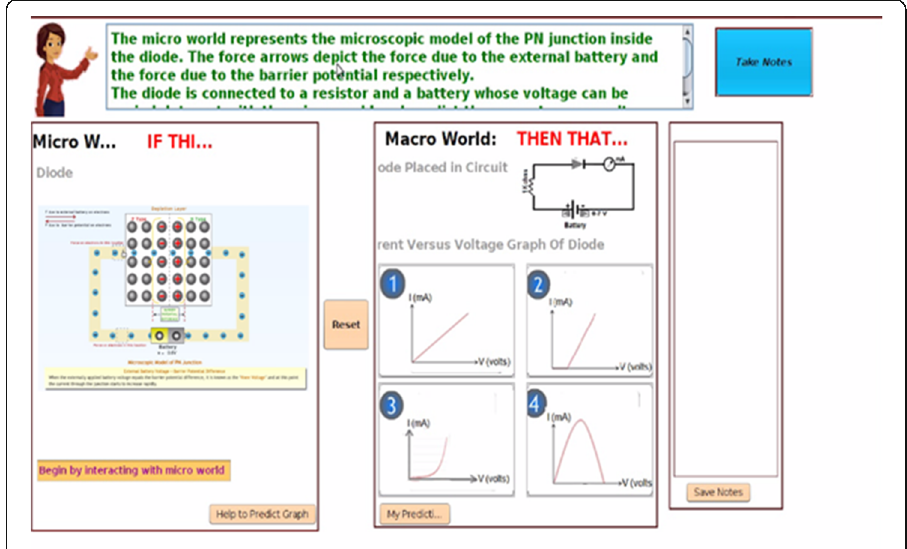
Fig. 11 MIC-O-MAP with the pedagogical agent (left-hand side top), microscopic simulation and prediction question displayed simultaneously, and note taking (right-hand side